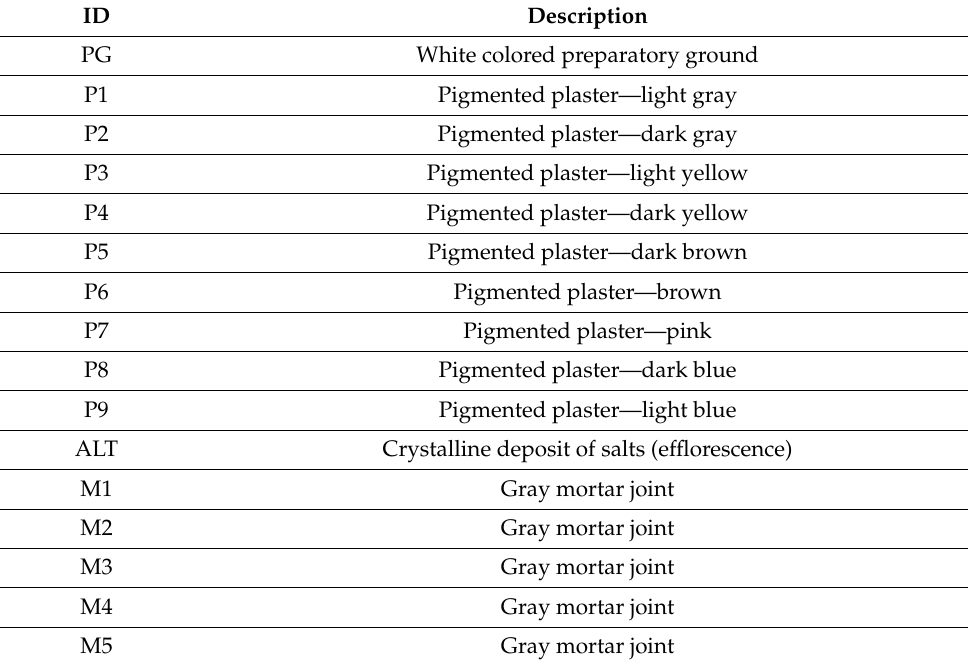
Table 1. A list of the analyzed points, together with a brief macroscopic